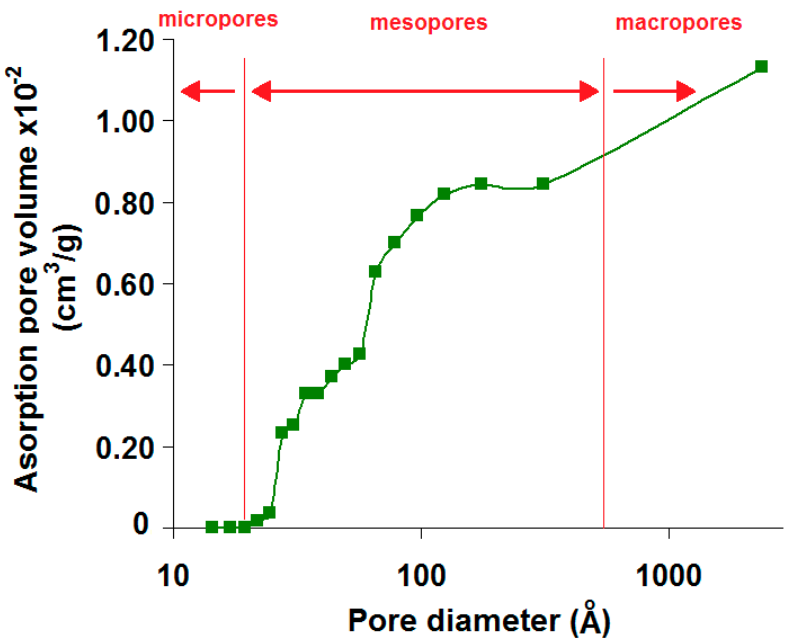
Figure 7. Nitrogen’s (N 2 ) physical adsorption–desorption isotherms of washcoat synthesized using aluminum dross and coal fly ash .